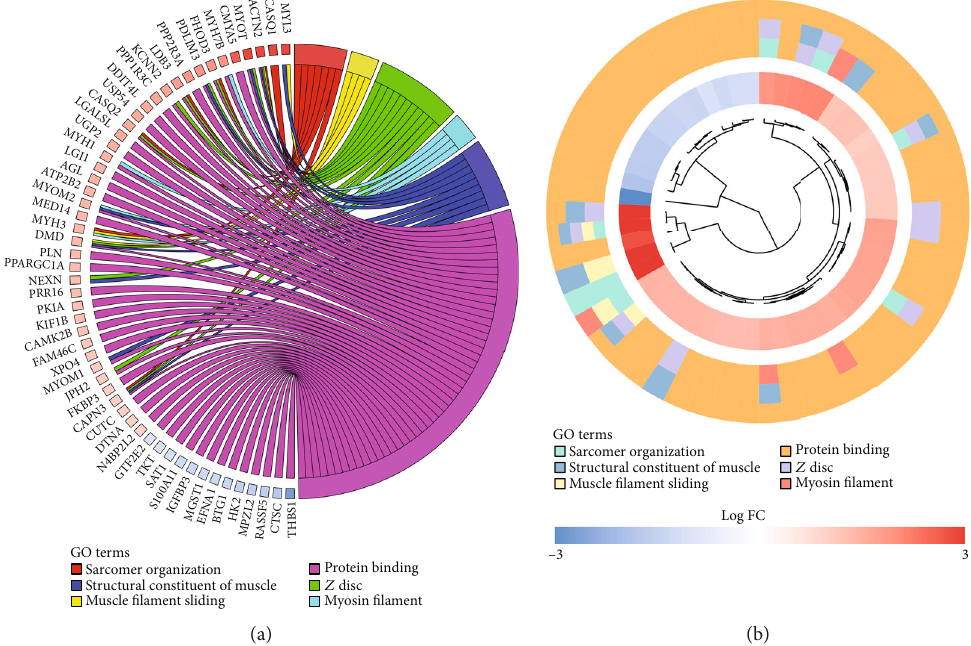
Figure 4: KEGG pathway enrichment results. (a) Relationships between DEGs and the top 5 enriched KEGG pathways. (b) Cluster plots corresponding to DEGs and the top 5 enriched KEGG